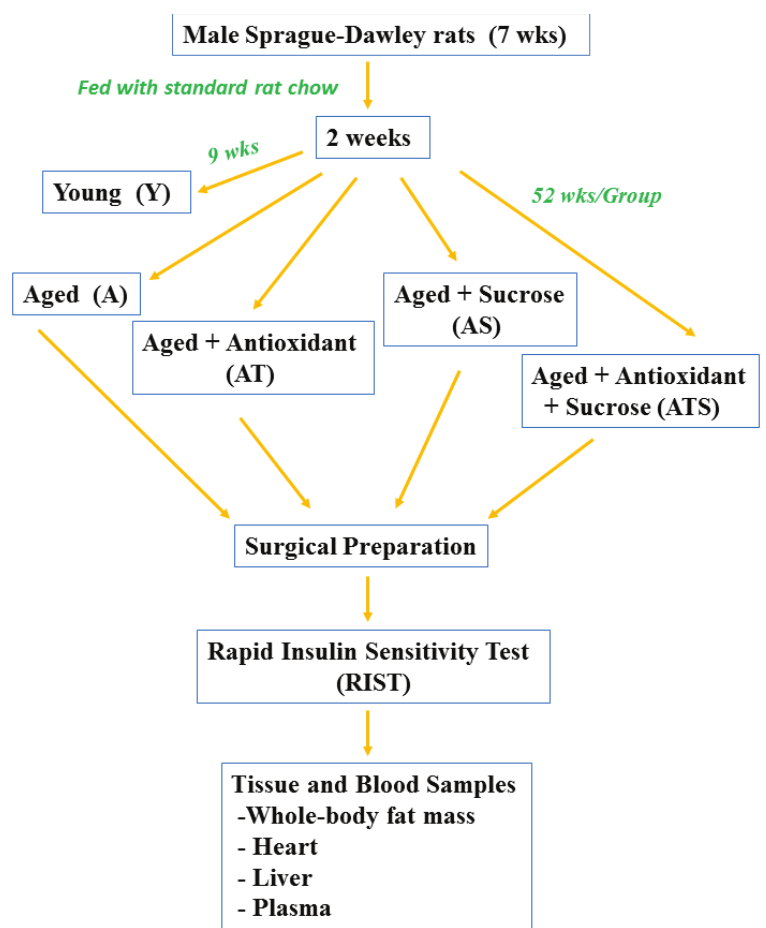
Figure 1. The methodology flow chart for testing animals. wks = weeks of